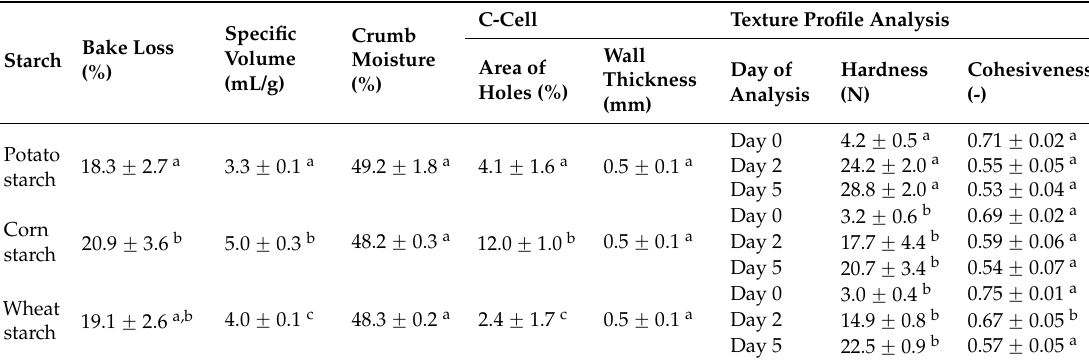
Table 2. Overview of the baking results: Results are shown as the mean values ˘ confidence interval of at least nine